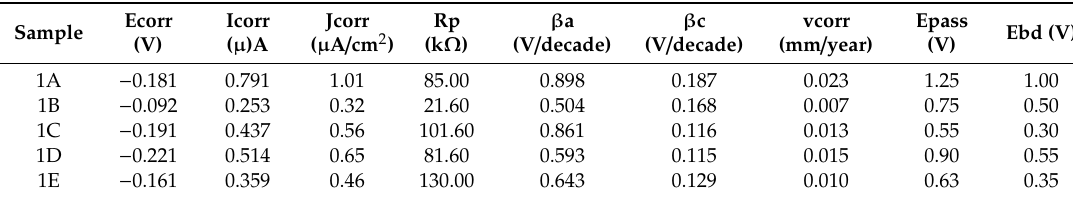
Table 4. Corrosion parameters in NaCl 0.9%.